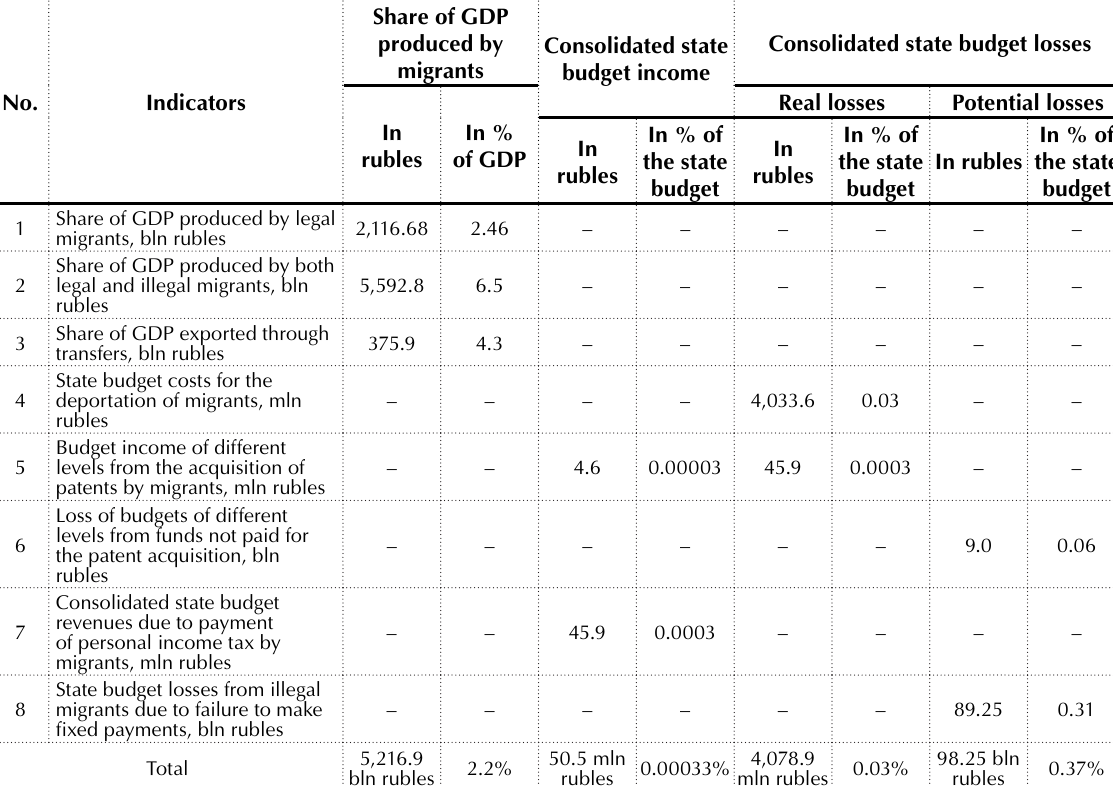
Table 4. Results of using the migrant workers in the Russia’s economy in 2016 Source: Compiled by the authors according to calculations made earlier.